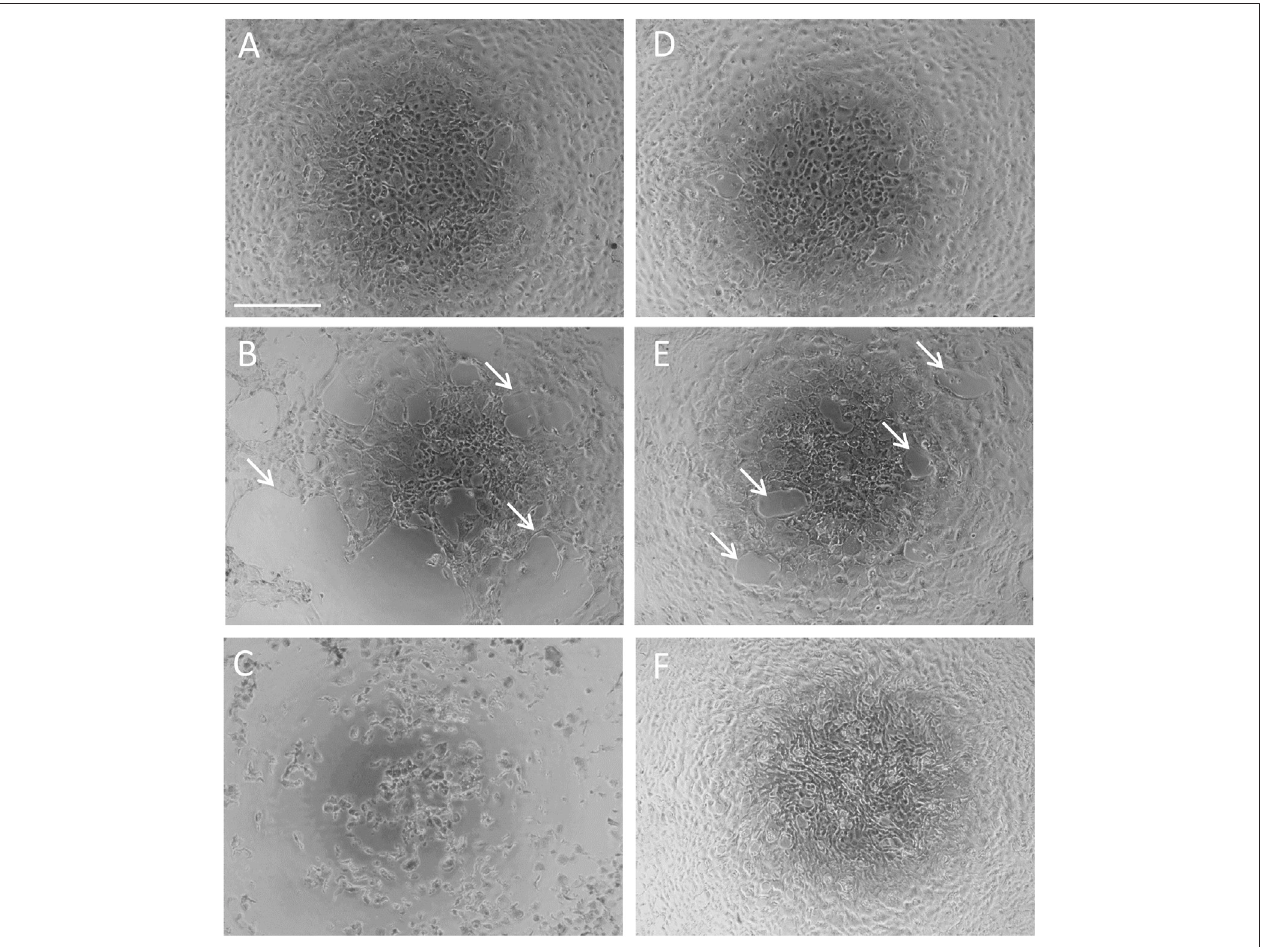
FIGURE 3 | Effect of P2X7R inhibition on acrolein-induced changes in cell morphology. Con fl uent primary cultured urothelial cells under normal culture conditions (A) . Cells were treated with acrolein (50 µM) for 2 h (B) or overnight (C) . Cells were treated with the selective P2X7R antagonist A804598 (10 µM) overnight (D) . Cells were pre-incubated with A804598 (10 µM) for half an hour and then treated with acrolein (50 µM) for 2 h (E) or overnight (F) . Magni fi cation bar shows 100 µm. White arrows indicate the disruption of cell-cell adhesions.